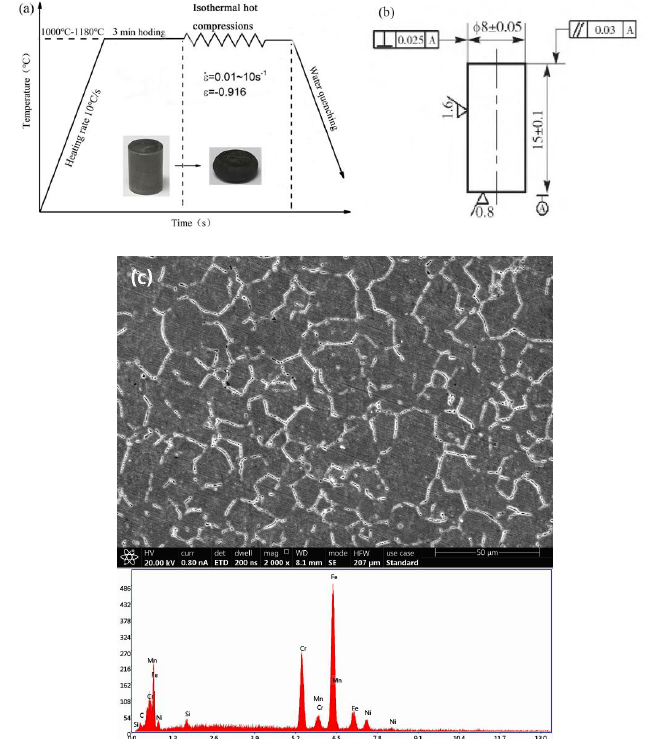
Figure 1. ( a ) Experimental scheme, ( b ) workpiece size, ( c ) and original metallographic structure of the 3Cr23Ni8Mn3N steel and energy spectrum diagram.